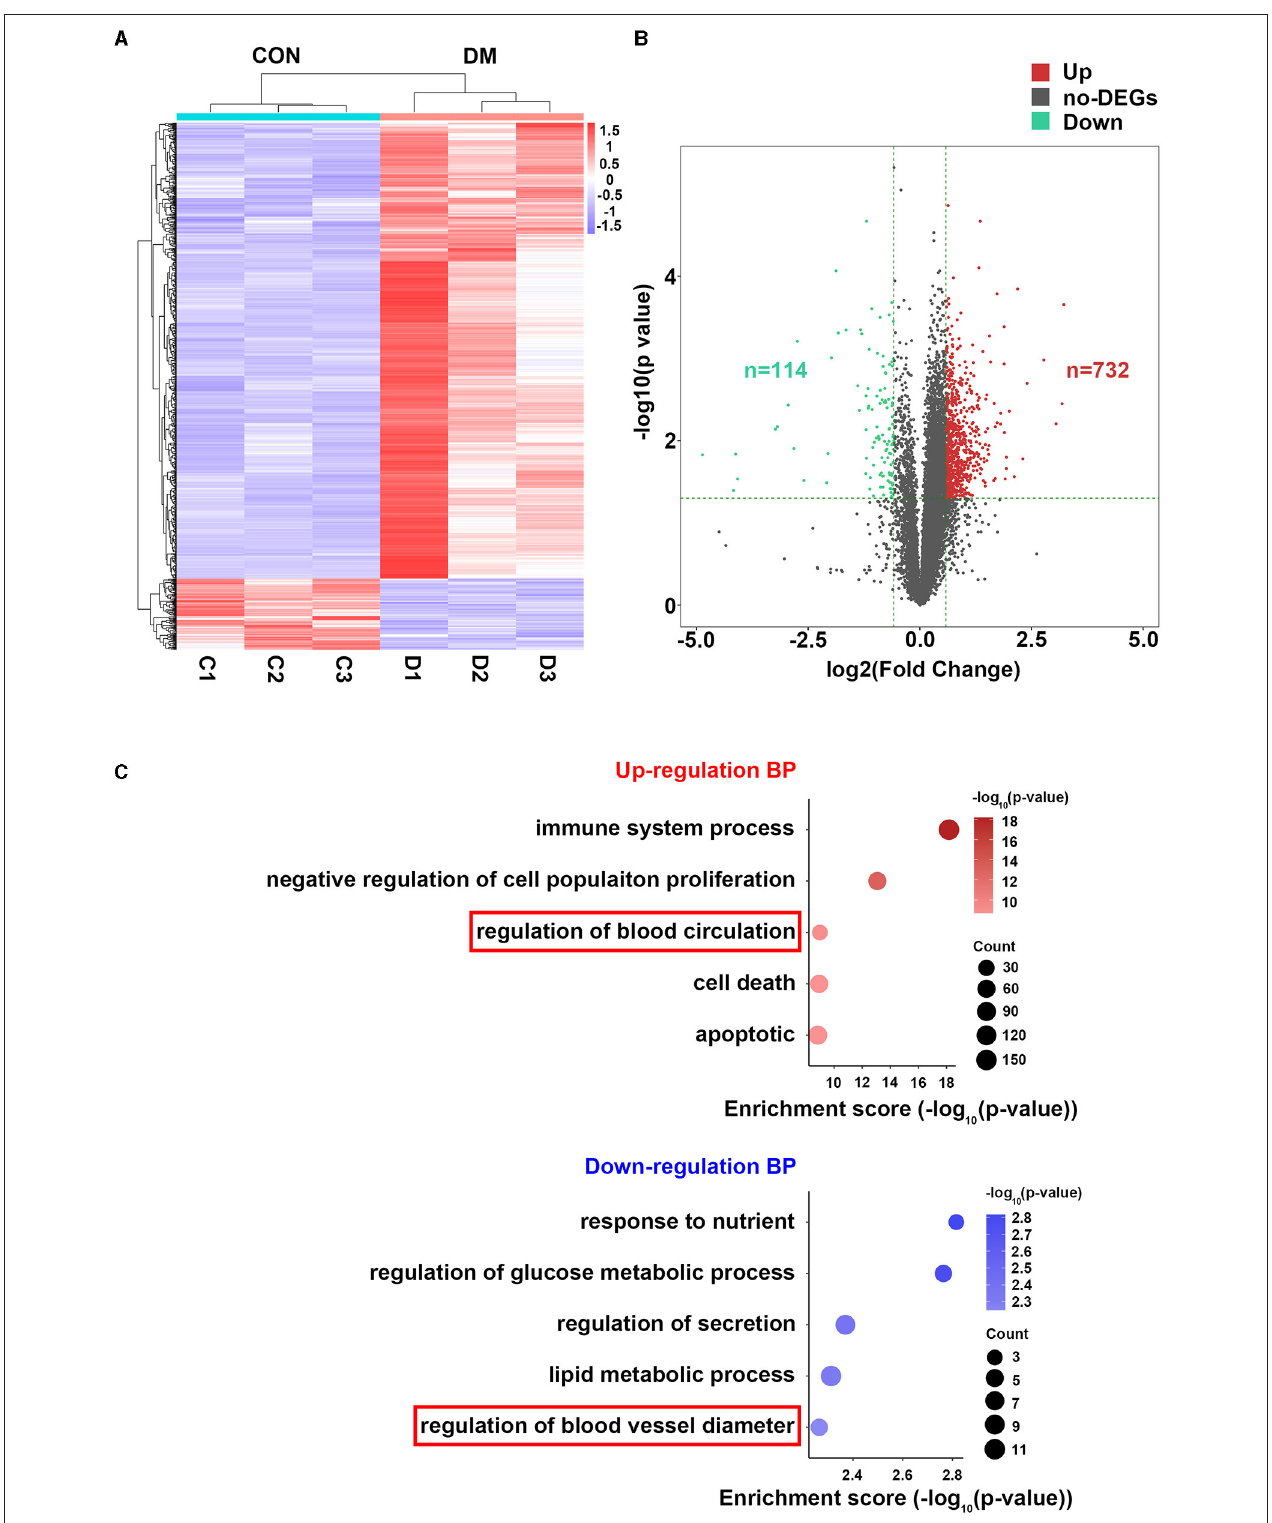
FIGURE 4 | Bioinformatics analysis of LGs from type 2 diabetic mice and vehicles after 24 weeks of HFD and STZ treatments. (A) Heatmap showing the differentially expressed genes (DEGs) between LGs from diabetic mice and vehicles. N = 3/group. (B) Volcano plot showing all the DEGs between LGs from diabetic mice and vehicles. There were 732 upregulated genes and 114 downregulated genes in the diabetic group. (C) The GO analysis of enrichment of upregulated BP and